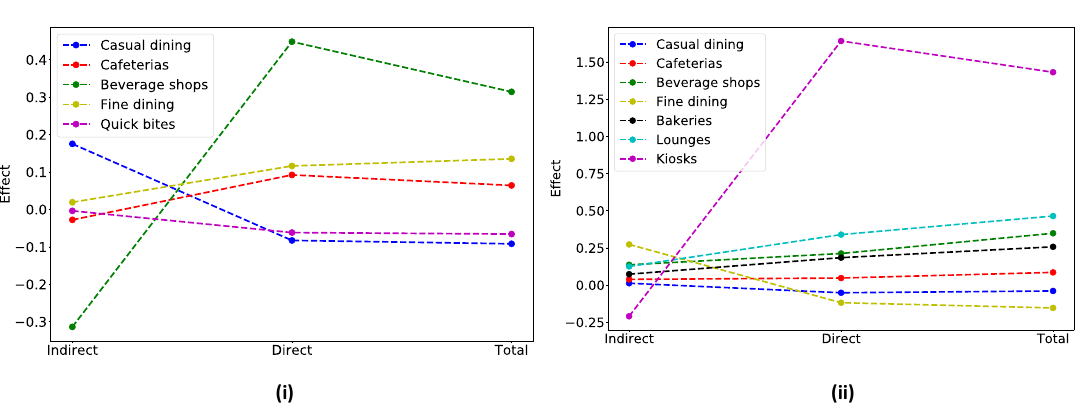
Figure 5. Indirect, direct and total effect of significant restaurant categories in ( i ) afternoon and ( ii ) evening (no significant effects in